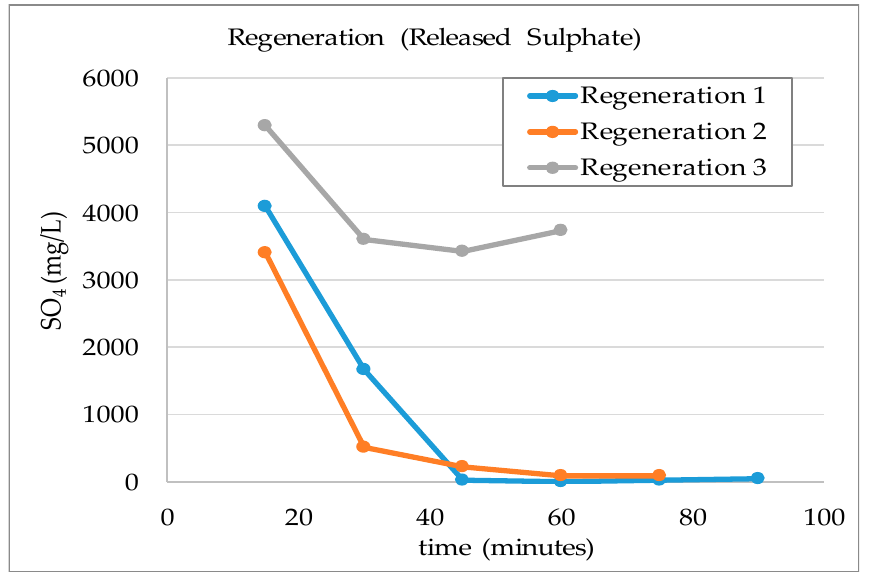
Figure 6. Desorption of sulphate ions from the resin at regeneration stage.